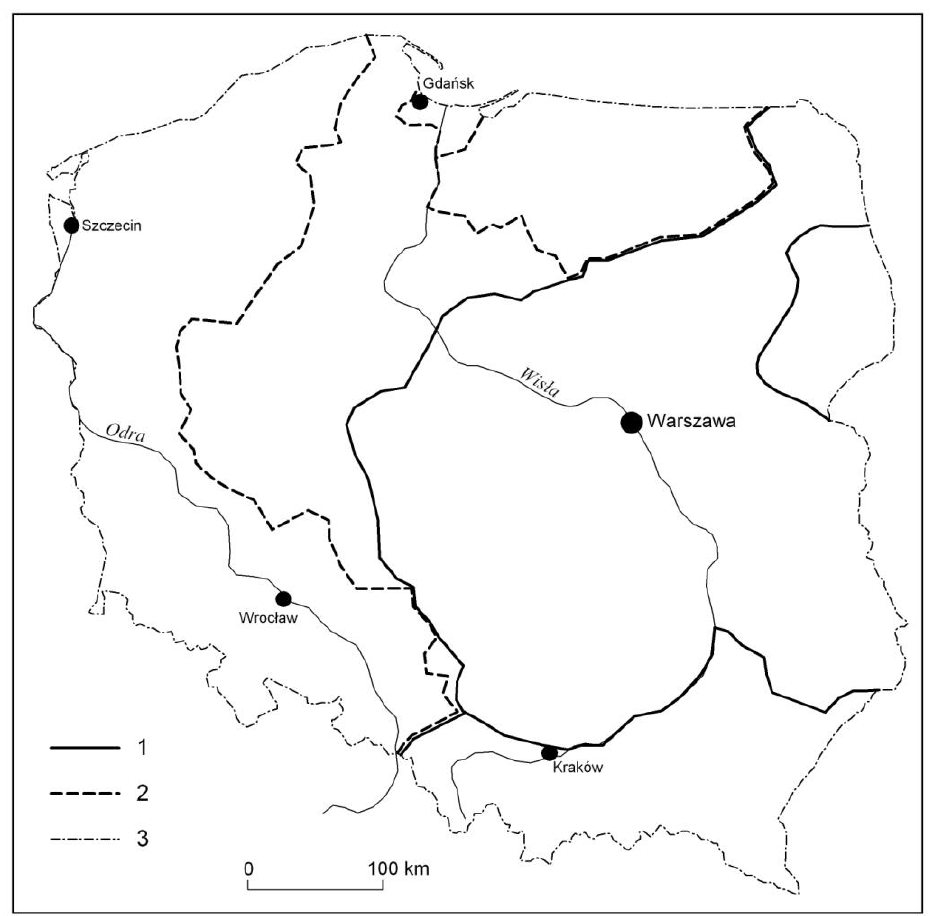
Fig. 1. Changeability of political borders on the area of contemporary Poland in the 19 th and 20 th century 1 – borders of countries in the period 1810-1914, 2 – borders of Poland in the period 1923-1939, 3 – contemporary borders of Poland (source: by author on the base of: Historical Atlas of World,